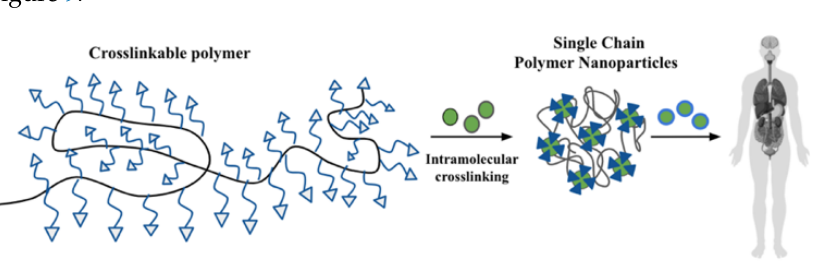
Figure 9. Polymer Chain Collapse—Distinct molecules are fabricated due to the precursor chain control that can direct the nanoparticle properties. Through intramolecular crosslinking, the polymer is fabricated to form single chain polymer NPs that find various applications in the human body. The advantages and limitations of these various methods of collagen NP preparation have been discussed in Table 1. Table 1. Advantages and limitations of collagen NP preparation